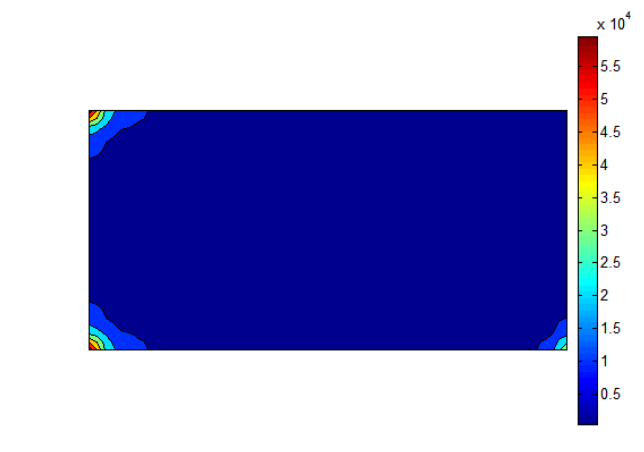
(c) Contours of von Misses stress. Fig.3. Stresses on rectangular